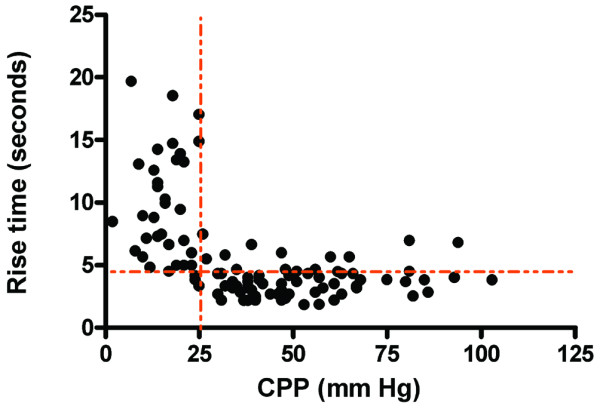
Cerebral perfusion pressure (CPP) and near infrared spectroscopy derived rise time. n = 76 measurements in 20 animals.